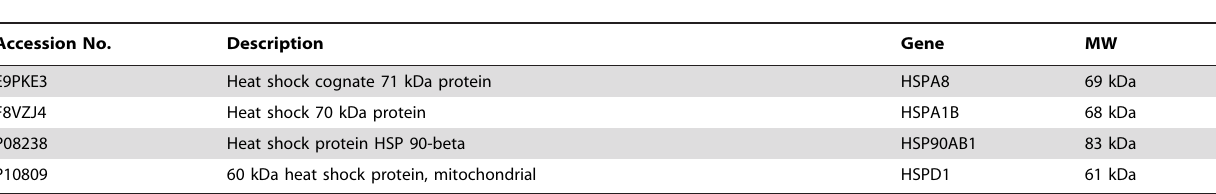
This table indicates the major bands form Figure 7 located around 60–80 kDa on the gel.